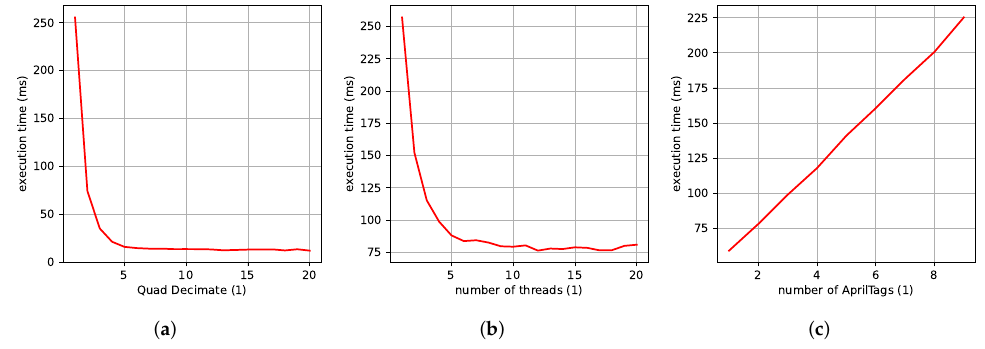
Figure 15. Impact on the algorithm’s execution time: ( a ) different quad decimate values where one thread is used and nine AprilTags are in the camera’s field of view, ( b ) different numbers of threads where quad decimate is set to one and nine AprilTags are in the camera’s field of view and ( c ) different numbers of AprilTags in the camera’s field of view where quad decimate is set to one and one thread is